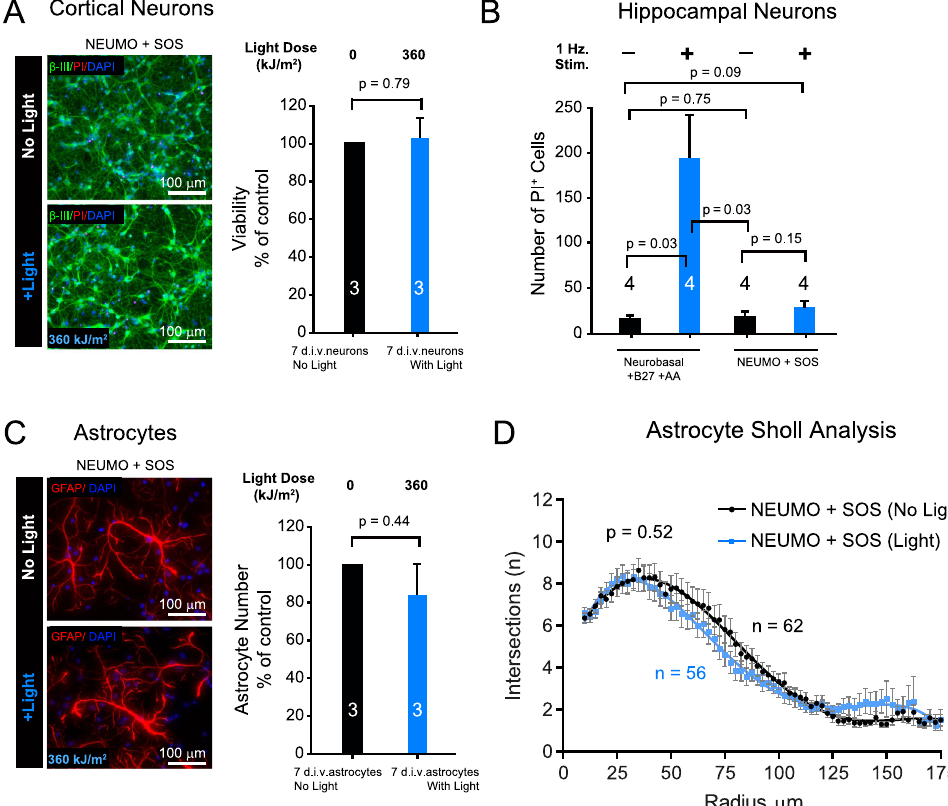
Figure 3. Light induced cytotoxicity can be prevented with new culture medium. ( a ) Viability of 7 d.i.v. β -III + cortical neurons ± light at indicated dose in NEUMO (in replacement of Neurobasal) and SOS (in replacement of B27) using PI exclusion assay. ( b ) Number of PI positive cells in 7 d.i.v. hippocampal neuronal cultures ± optogenetic stimulation at 1 Hz in control media conditions (Neurobasal + B27) with additional antioxidants (AA) and in NEUMO + SOS. Note: the protection of cortical and hippocampal neurons during treatment with light only in NEUMO + SOS media conditions. ( c ) Representative images and quantification of GFAP + astrocyte numbers in 7 d.i.v. cortical neuron enriched cultures after ± light at indicated dose in NEUMO + SOS. ( d ) Non-linear fitted plots from Sholl Analysis of astrocytes kept in the dark (black line: 62 cells analyzed) or exposed to light (blue line: 56 cells analyzed) and p value calculated from two tailed unpaired t-test of mean intersection number. All above histograms are normalized to controls (with the exception of b ) and data represents means ± s.e.m. of a number of biological replicates (value within or above each histogram) and p -values from Student’s two tailed unequal variance t-test. Black and blue histograms represent conditions kept in the dark or exposed to light respectively. Light doses in kJ/m 2 are shown above histograms and as insets within representative images of irradiated experiments. Cell culture media conditions are described above images and under respective